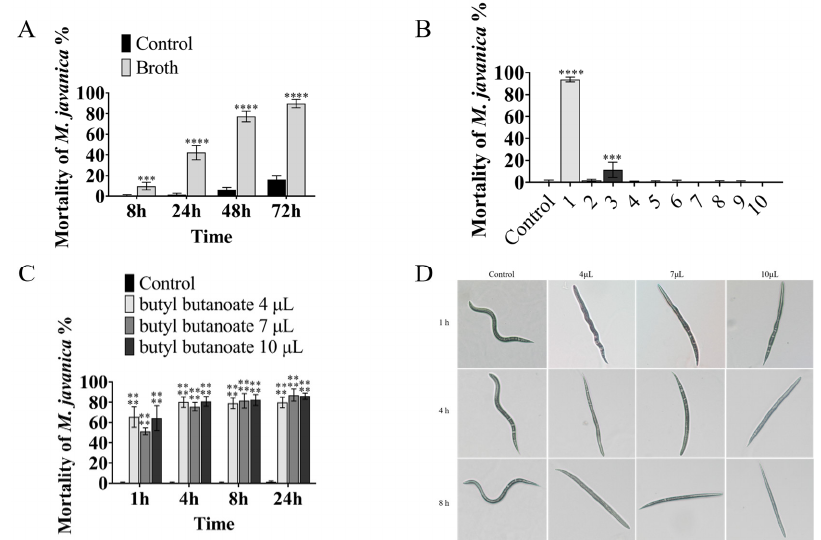
Figure 1. The nematicidal activity of the B. diminuta -specific VOCs. Bars refer to the standard error of the means (n = 3). The asterisk above the columns represents a significant difference using ANOVA, **** mean p < 0.0001; *** mean p < 0.001: ( A ) the mortality of nematodes after treatment with broth or control; ( B ) the nematicidal activity of 10 VOCs produced by B. diminuta , 1–10 were butyl butanoate, 2- (1-hydroxycyclohexyl)cyclohexan-1-one, 2- (cyclohexen-1-yl)cyclohexan-1-one, tetrade- cane, butylcyclohexane, dodecane, bis (6-methylheptyl) benzene-1,2-dicarboxylate, dibutyl benzene- 1,2-dicarboxylate, ( 6E , 10E , 14E , 18E )-2,6,10,15,19,23-hexamethyltetracosa-2,6,10,14,18,22-hexaene and cyclohexylcyclohexane; ( C ) different doses of butyl butanoate; ( D ) the status of butyl-butanoate- treated nematodes.